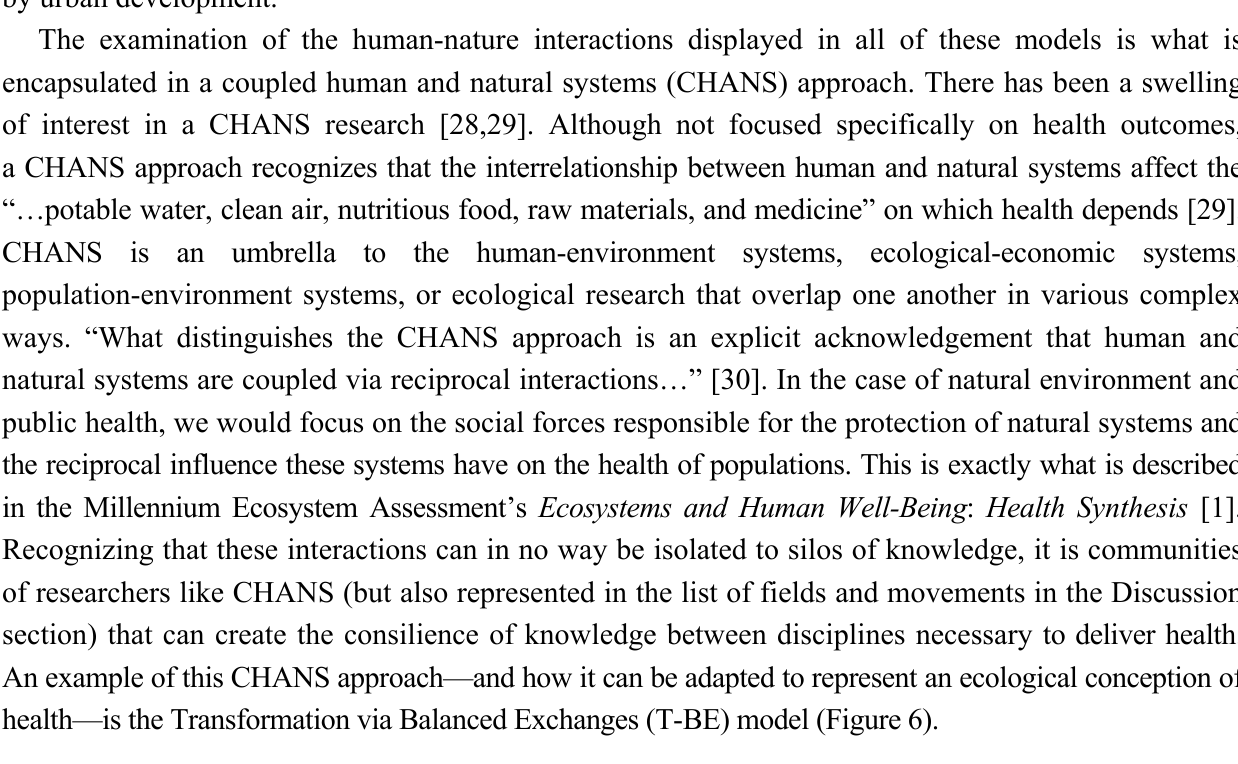
Figure 6. Transformation via Balanced Exchanges